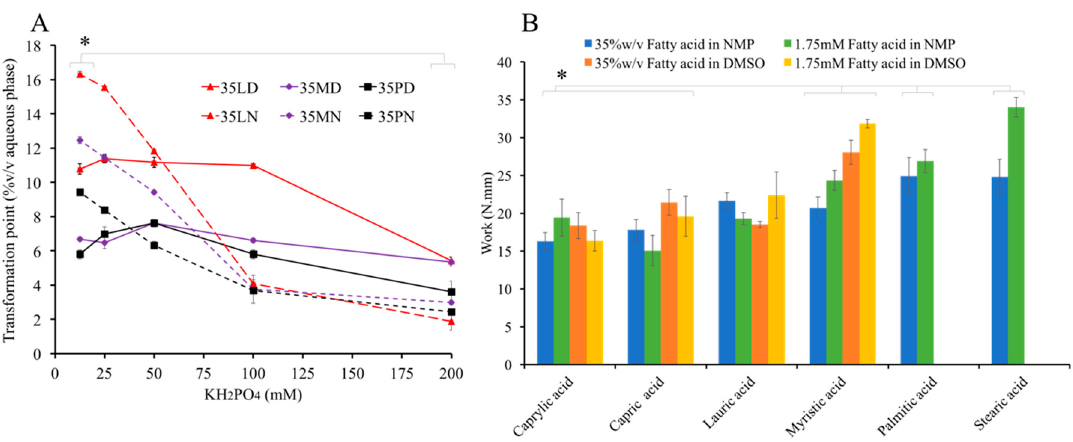
Figure 5. Effect of KH 2 PO 4 concentration on transformation point ( A ). Injectability of preparations (work) ( B ) (triplicate testing; n = 3). * represents p <